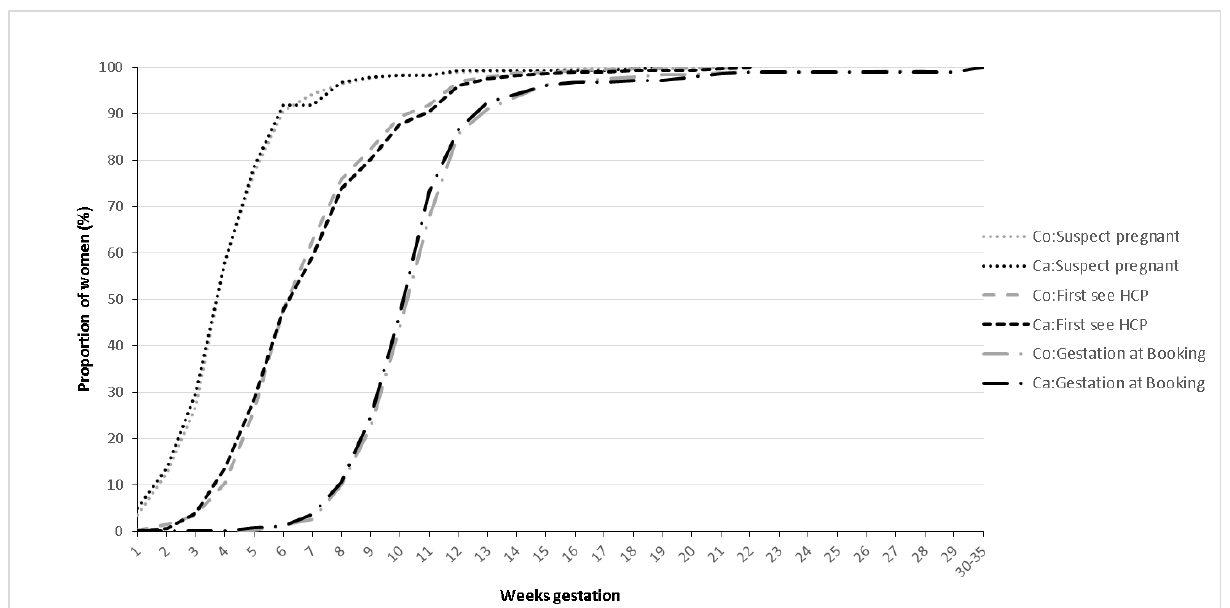
Figure 2: Cumulative frequency of gestational age when pregnancy first suspected, at first contact with a Health Care Professional (HCP) about the pregnancy, and at booking appointment with midwife, for cases and